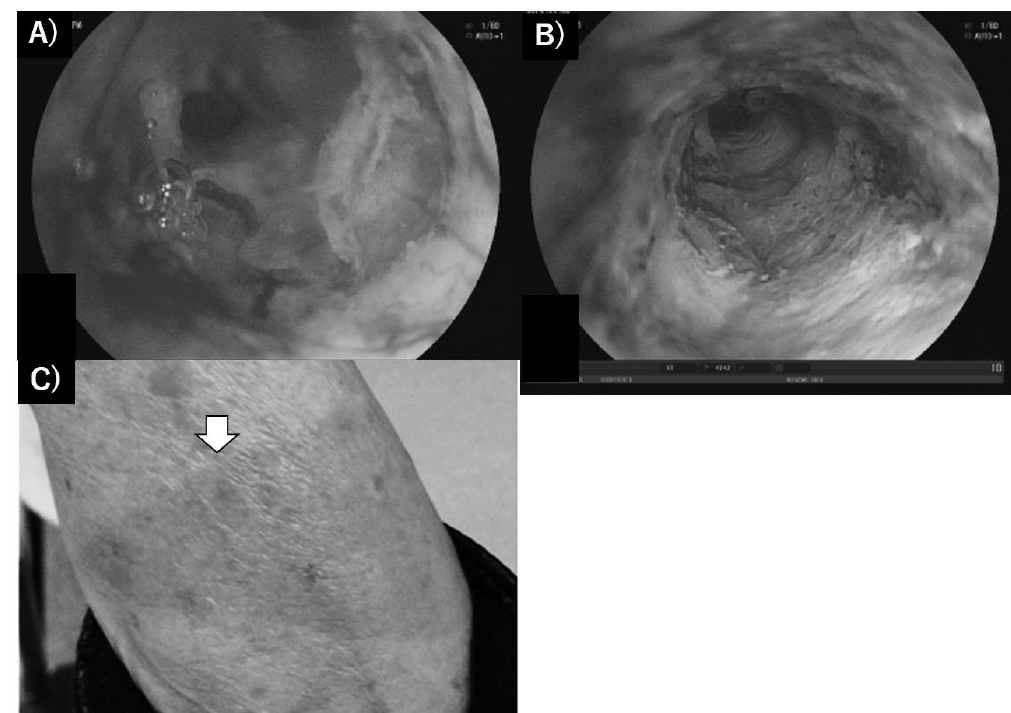
Figure 2. ( A ) Cholangioscopy findings showed encircled cancer stenosis; ( B ) stenosis was released by cancer shrinkage with a white necrotic plaque and reddish tissues after PDT; ( C ) mild photo-reaction of the forearm at day 7 after PDT.